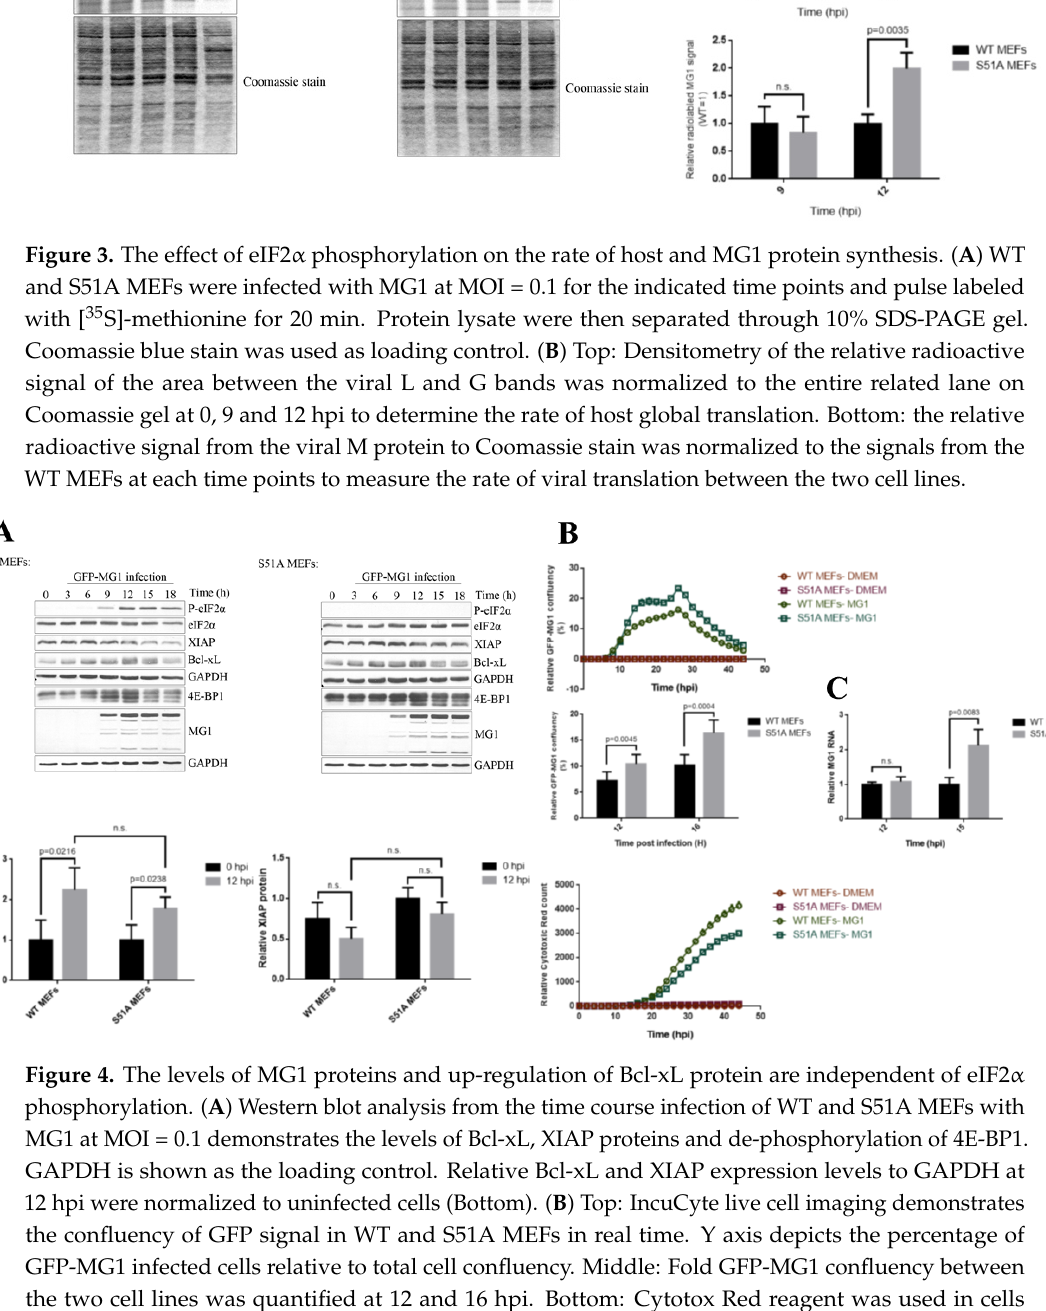
Figure 3. The effect of eIF2 α phosphorylation on the rate of host and MG1 protein synthesis. ( A ) WT and S51A MEFs were infected with MG1 at MOI = 0.1 for the indicated time points and pulse labeled with [ 35 S]-methionine for 20 min. Protein lysate were then separated through 10% SDS-PAGE gel. Coomassie blue stain was used as loading control. ( B ) Top: Densitometry of the relative radioactive signal of the area between the viral L and G bands was normalized to the entire related lane on Coomassie gel at 0, 9 and 12 hpi to determine the rate of host global translation. Bottom: the relative radioactive signal from the viral M protein to Coomassie stain was normalized to the signals from the WT MEFs at each time points to measure the rate of viral translation between the two cell lines.